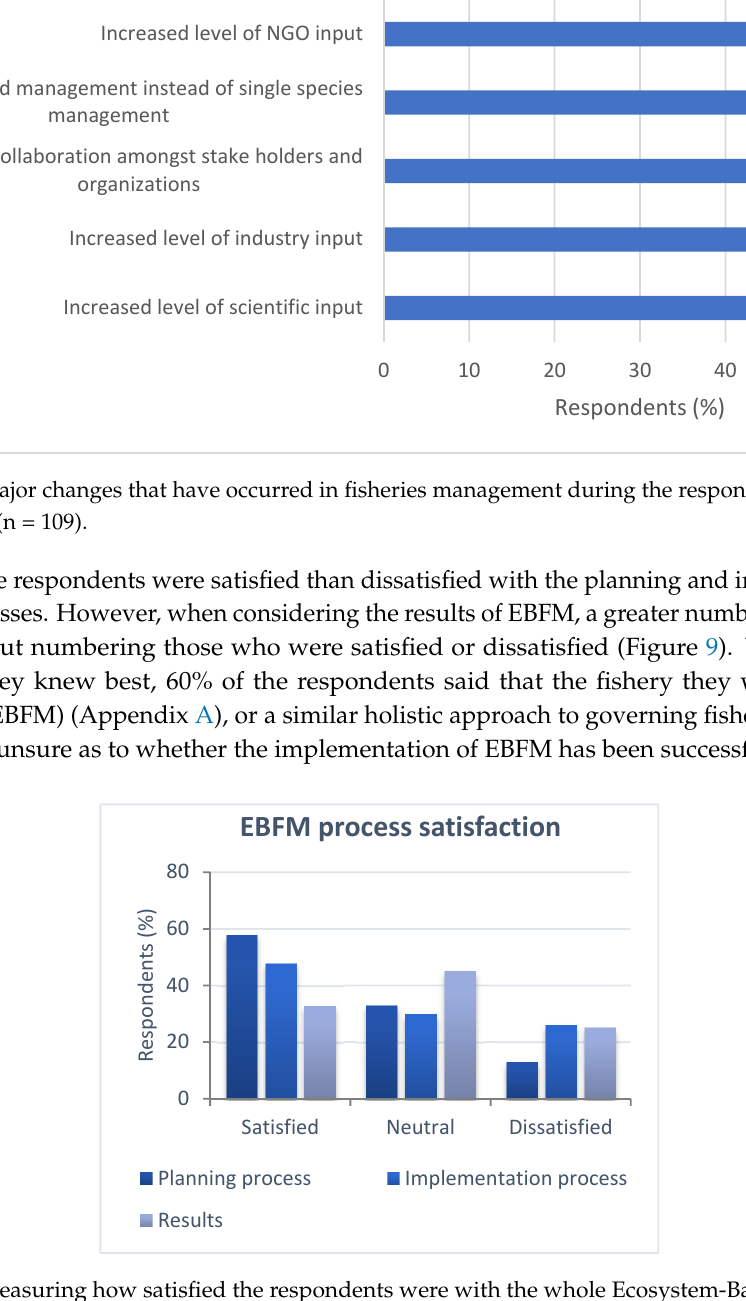
Figure 9. Measuring how satisfied the respondents were with the whole Ecosystem-Based Fisheries Management (EBFM) process (n = 104).